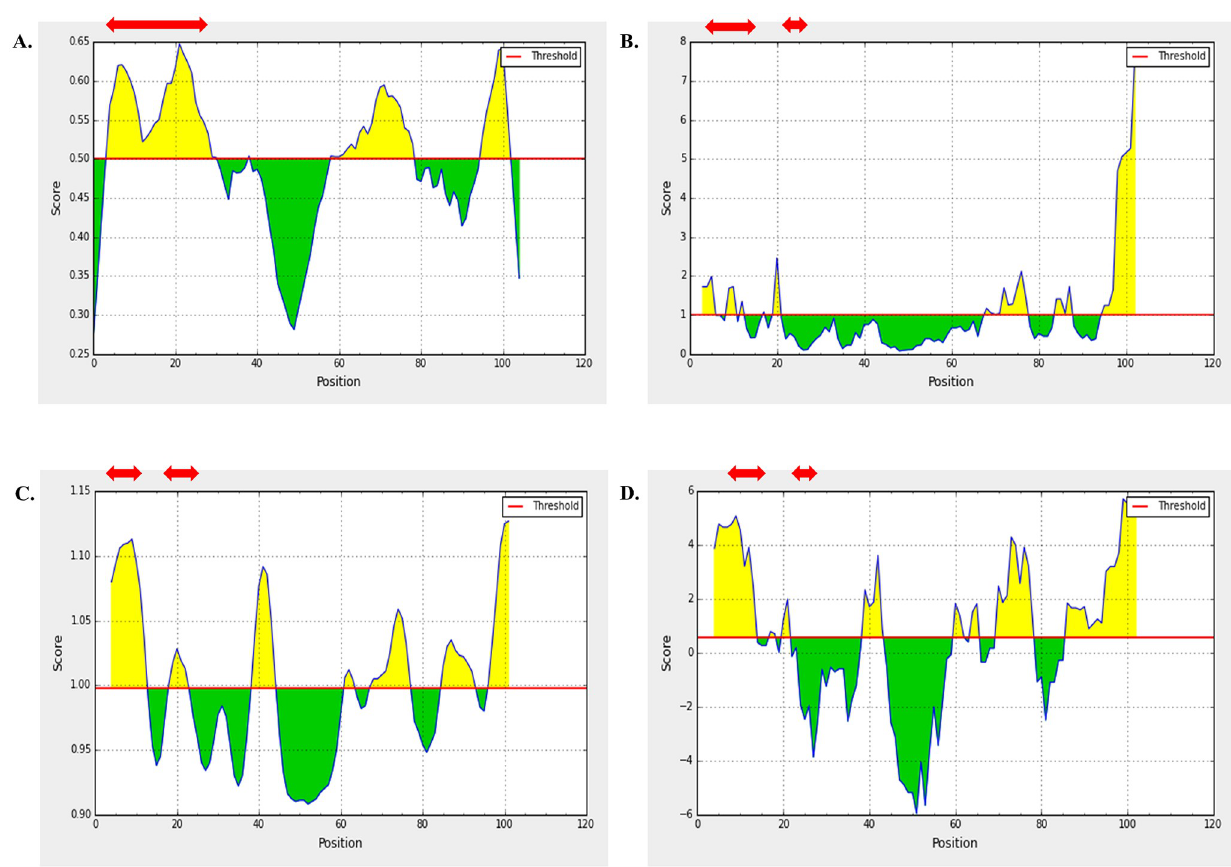
Fig 1. B cell Epitope prediction of Capsid C protein at IEDB linear epitope prediction tool. Predicted peptide regions above the threshold values (yellow region) are shown in red arrow. Methods used for prediction are enlisted as: (A) BepiPred 2.0, (B) Emini Surface Accessibility tool, (C) Karplus & Schulz Flexibility tool, and (D) Parker Hydrophilicity